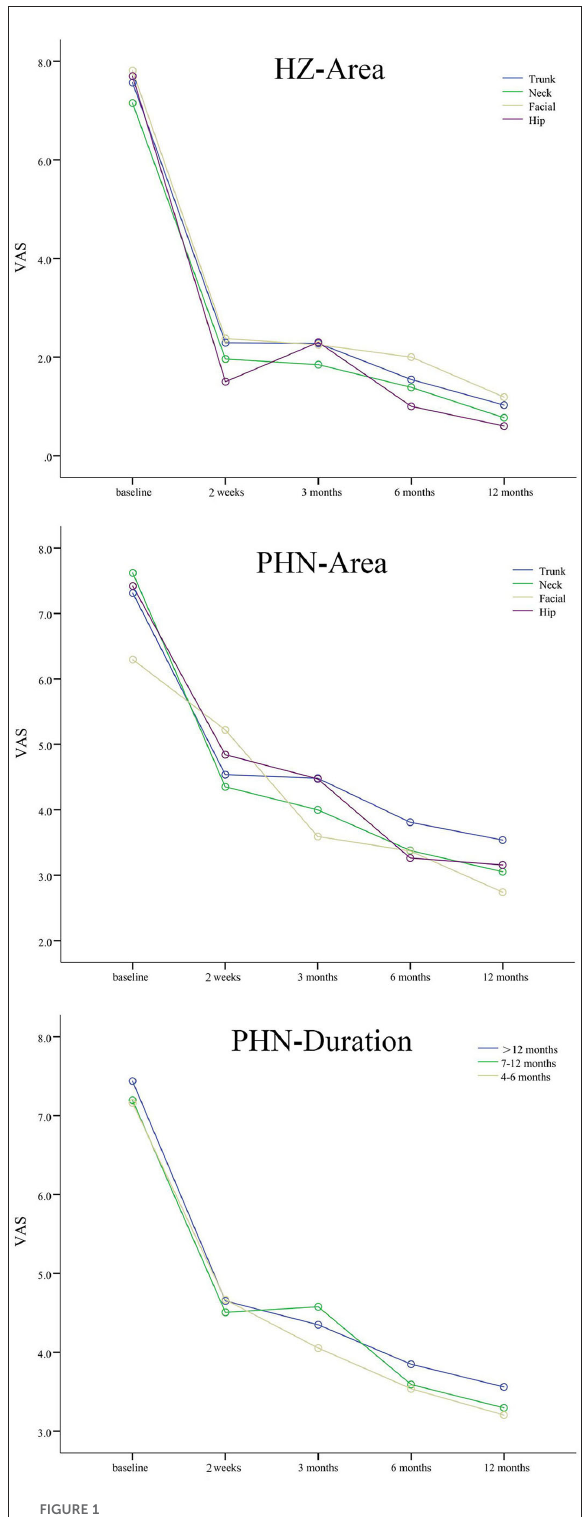
FIGURE1 The VAS scores of patients with HZ and PHN. Different colored lines mean different pain areas and durations. The VAS scores decreased significantly from baseline to 2 weeks, 3, 6, and 12 months after interventions in patients with different pain durations and